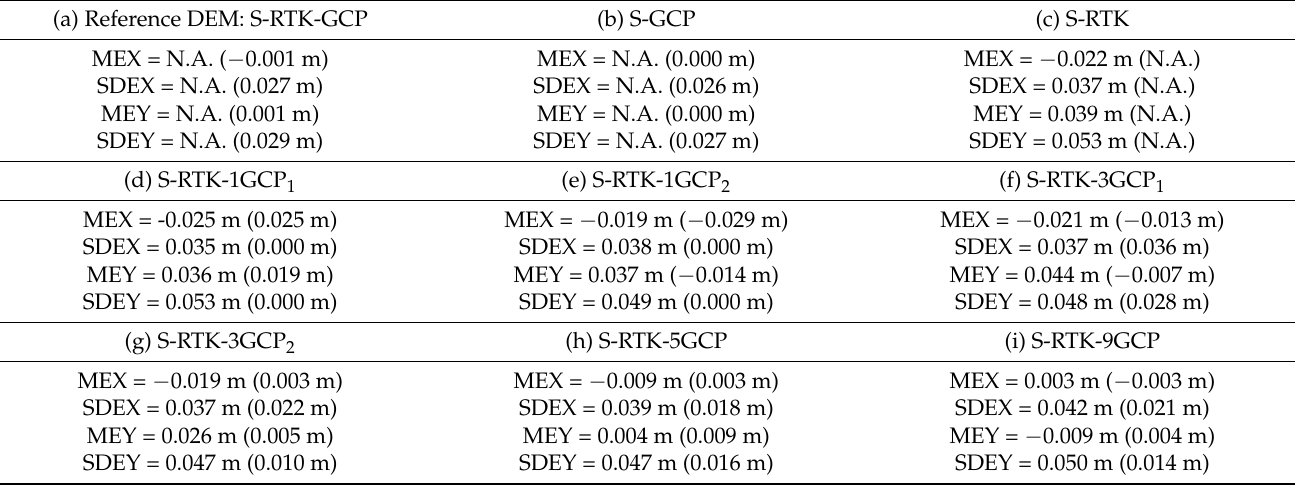
Table 5. Planimetric error (X easting and Y northing) evaluation for the different scenarios presented in Figure 3 using ground targets (GCPs and ChkPts) measured with RTK-GNSS. The values between brackets correspond to GCP-based